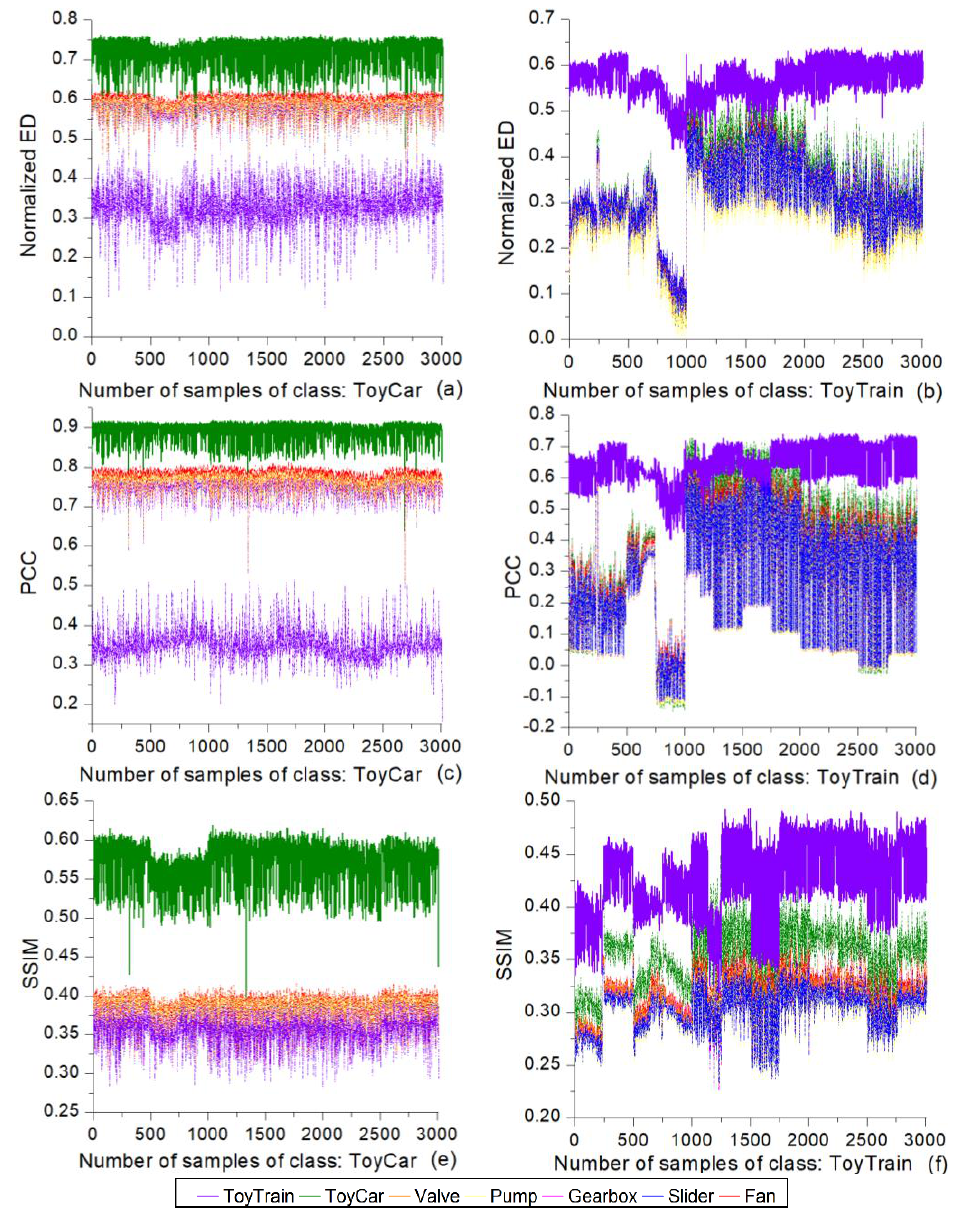
Figure 5. Mean per-sample line plots of all three measures for both intraclass (solid line) and inter-class similarity (dashed lines) for the full dataset: ( a ) ED normalized for toy-car class, ( b ) ED normalized for toy-train class, ( c ) PCC for toy-car class, ( d ) PCC for toy-train class, ( e ) SSIM for toy-car class, and ( f ) SSIM for toy-train class (legend is the same for all